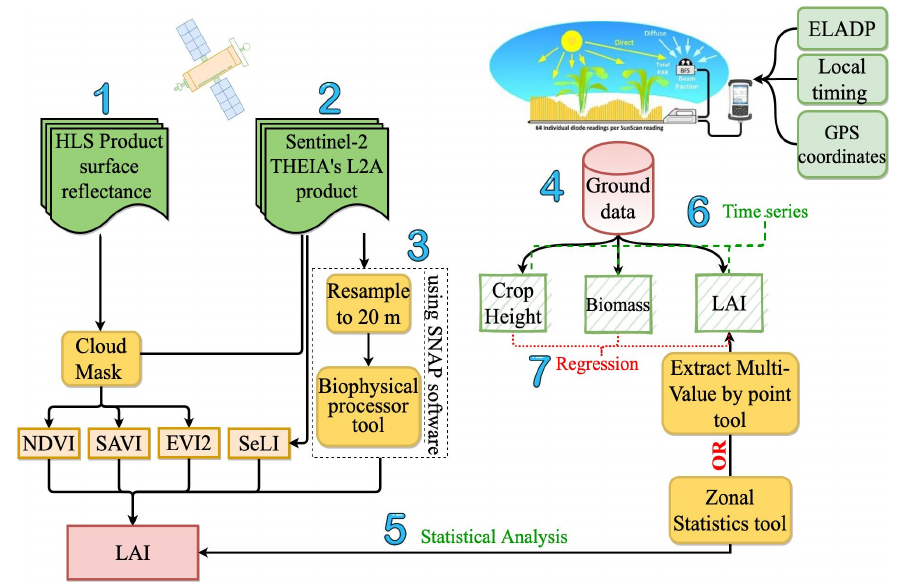
Figure 6 . Step ‐ by ‐ step flow chart for the validation of satellite ‐ derived LAI against the ground measured LAI. Components of the analysis include: ( 1 ) existing vegetation index (VI) relationships applied to Harmonized Landsat ‐ 8 and Sentinel ‐ 2 (HLS) surface reflectance generated by NASA, ( 2 ) THEIA L2A surface reflectance products from Sentinel ‐ 2, ( 3 ) the SNAP biophysical model, ( 4 ) ground ‐ truthing, ( 5 ) statistical comparison between the measured and the modeled LAI, ( 6 ) monitoring crop biophysical parameters during the 2019 growing season, and ( 7 ) investigation of crop ‐ specific height and above ‐ ground biomass relationships with LAI.